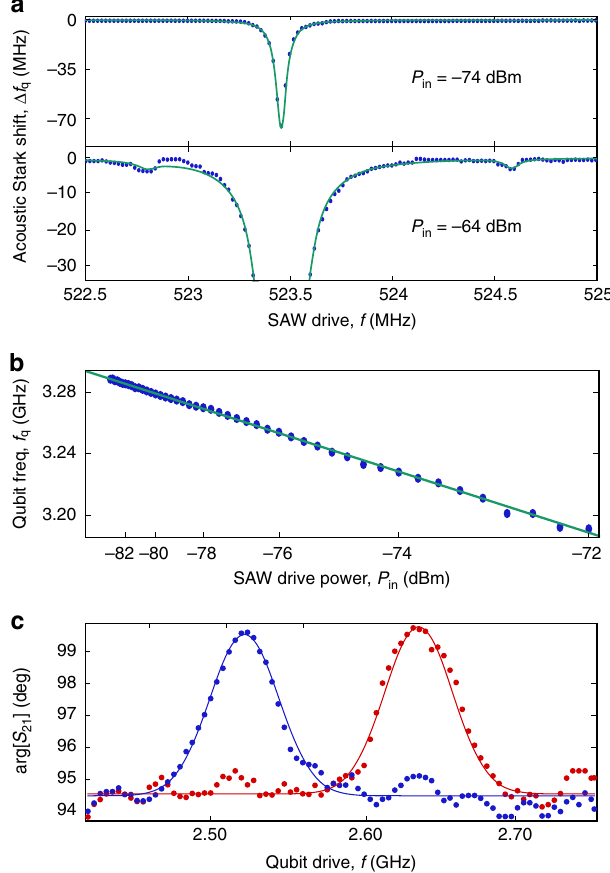
Fig. 4 Acoustic Stark shift. a Qubit frequency shift as a function of SAW drive at two different powers: − 74 dBm (top panel) and − 64 dBm (bottom panel). The green curves are Lorentzian fi ts to the data points. b Qubit frequency as a function of SAW drive power P in at a fi xed SAW frequency f fi t to the data. c Qubit m2 (blue points). The green solid line is a linear spectroscopy performed with the SAWR at two different fl ux values [0.395 Φ 0 (red points) and 0.403 Φ 0 (blue points)]. The solid lines are gaussian fi ts to the data